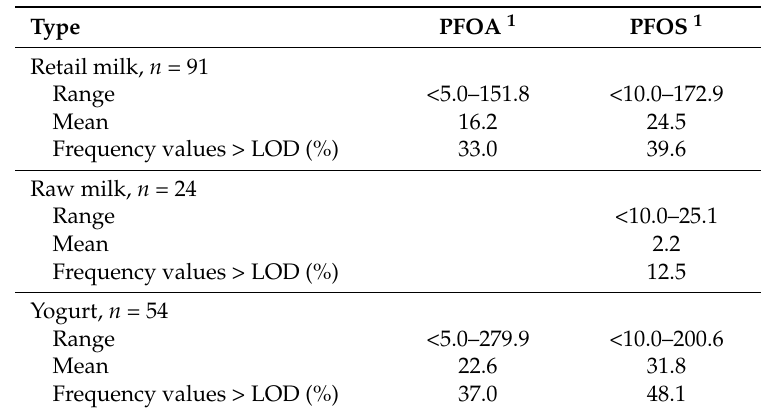
Table 2. Concentrations (ng/L) of PFOA and PFOS in milk and yogurt